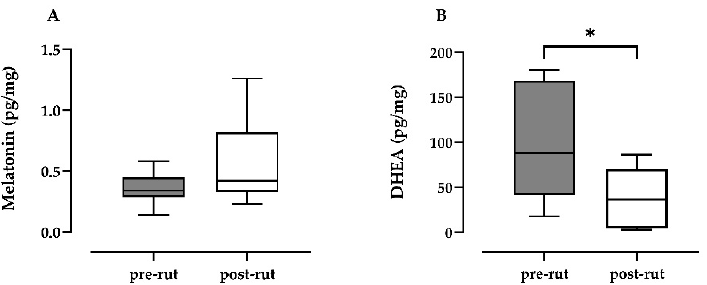
Figure 1. Differences between pre-and post-rut groups for the quantification of testicular parenchymal melatonin ( A ) and DHEA ( B ). *, p < 0.05. DHEA, dehydroepiandrosterone.